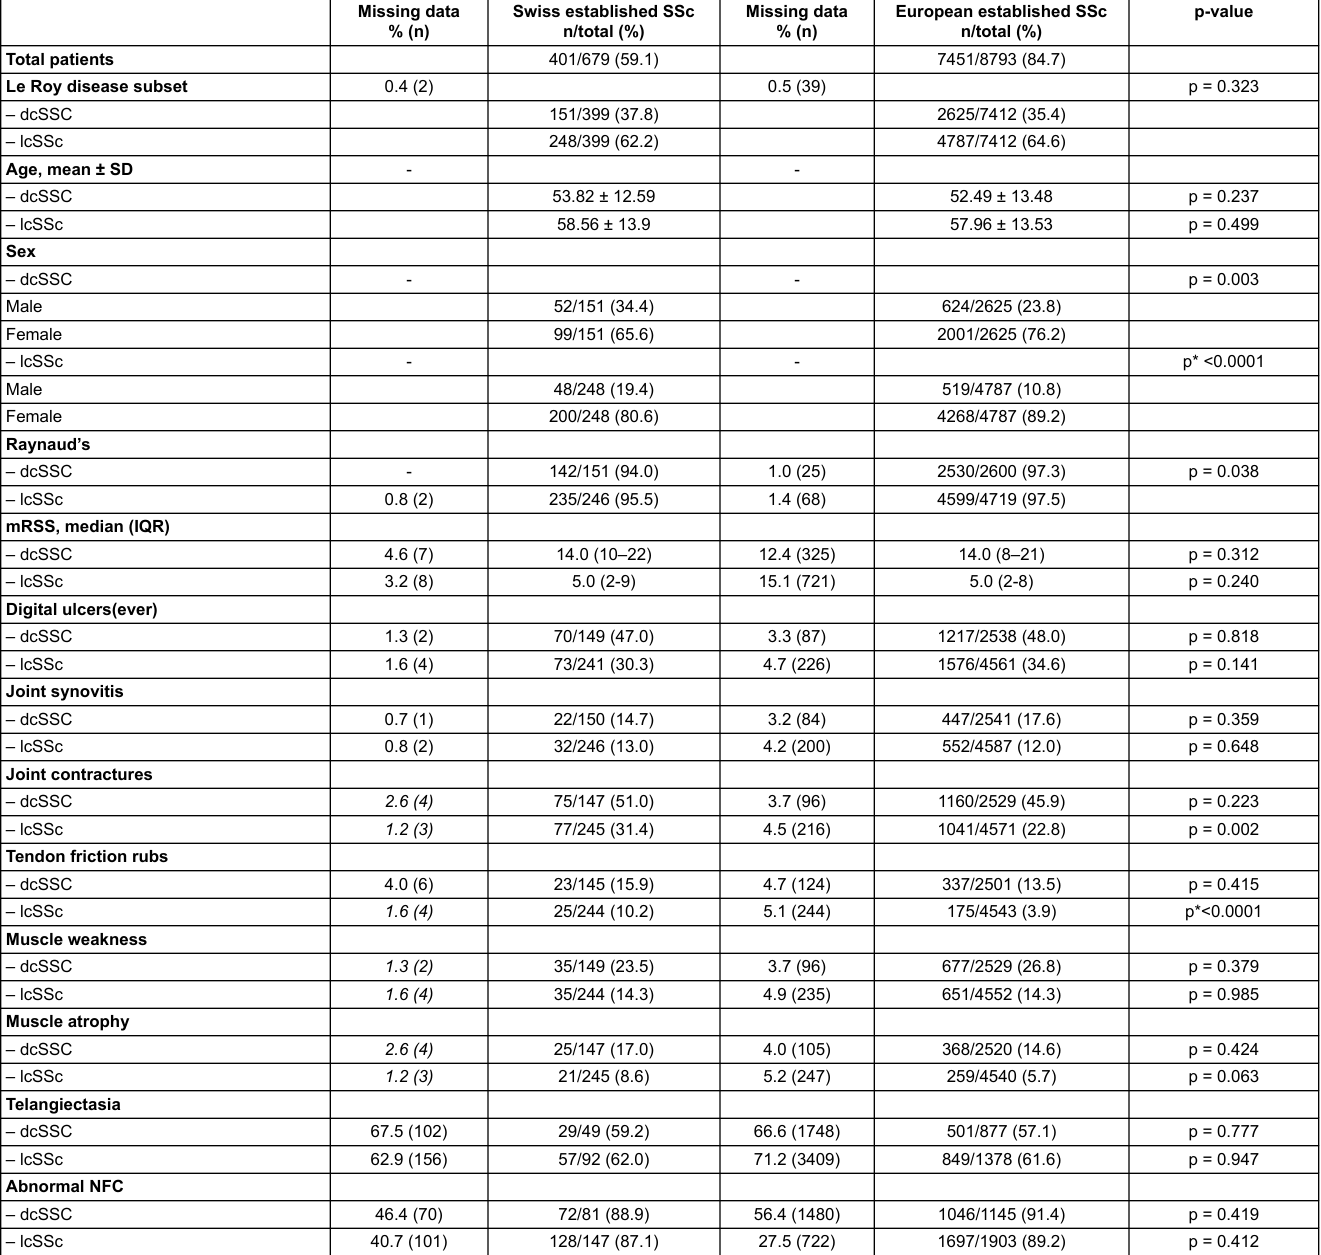
Table S2: Demographics and disease characteristics of Swiss and European established SSc